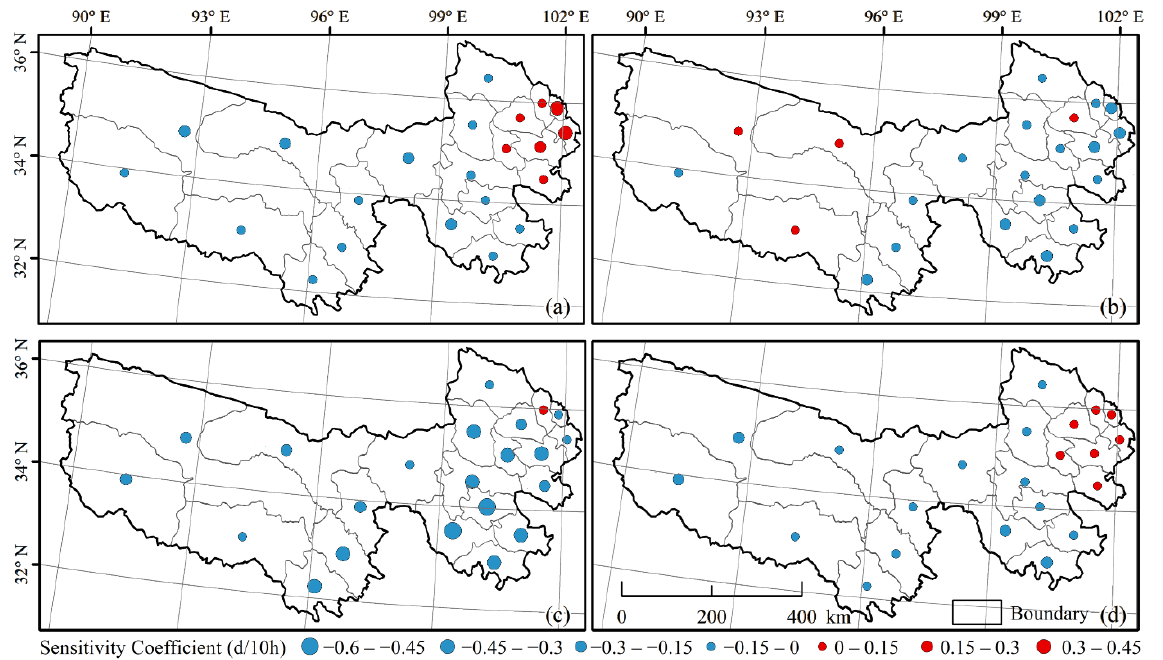
Figure 18. Spatial distribution of the partial correlation coefficients between the EOS of the vegeta- tion and sunshine duration in August ( a ), September ( b ), October ( c ) and August – October ( d ) in the Three-River headwaters region.